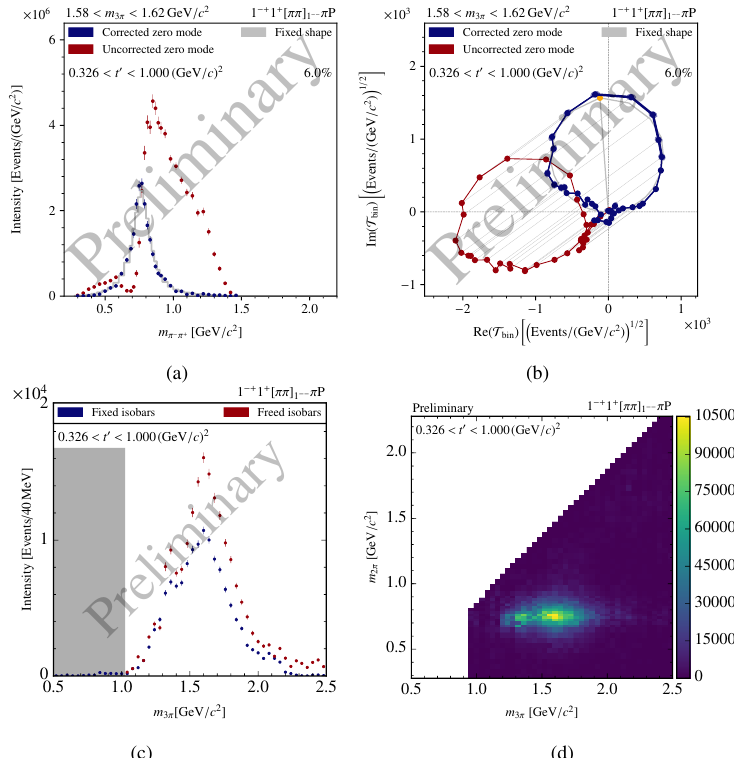
Figure 3: Intensity distribution (a) and Argand diagram (b) for the freed [ ππ ] P amplitude before (red) and after (blue) fixing the zero mode. The 1 − + 1 + [ ππ ] P π P intensity in m 3 π bins (c) from the freed-isobar PWA (red) and the fixed-isobar PWA (blue). Intensity of 1 − + as a function of m 3 π and m 2 π after fixing the zero mode